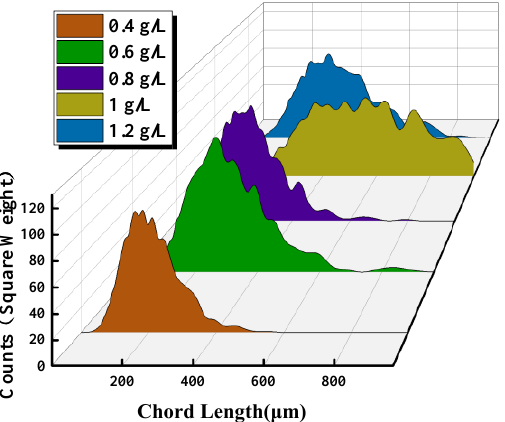
Figure 7. Weighted distribution of kaolinite suspension with different concentrations of PEO.